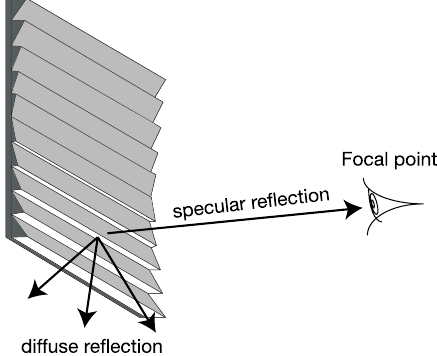
Figure 5. Detail of the active wall showing sections reflecting diffusively and sections reflecting